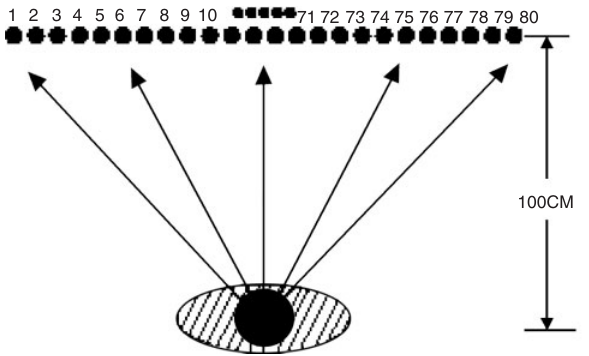
Figure 26 The natural eye calibration set-up. The subject is asked to stabilize his/her head in front of a board. The distance between the neighbour targets is constant. The distance between the subject and the board is set to 1 m. The deflection angle of the subject’s eye is determined from the distance between the start target dot and the end target dot. During the experiment, the subject is asked to look to the left, right and to the centre of the target board. Then the subject is asked to move his/her eye horizontally by looking at specific targets. Assume that the subject’s left end vision is T , right end is T , and L R . The distance between the subject and the target centre T C board is L . Then the subject’s eye deflection range is